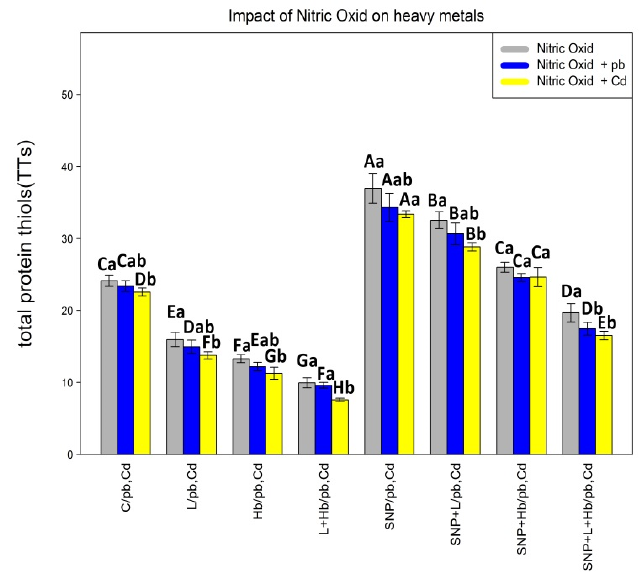
Figure 1. Effect of nitric oxide (NO) concentrations on protein, non-protein, and a total of thiol of A. pygmaea L. with 200 µ M Pb and 200 µ M Cd. The treatments contained various concentrations of nitric oxide alone or in combination with 200 µ M Pb and 200 µ M Cd. The capital letters showed statistically significant differences across various levels of nitric oxide alone or in combination with 200 µ M Pb and 200 µ M Cd (the bars with the same colors), while the lowercase letters showed statistically significant differences within each concentration of nitric oxide (NO) alone or in combination with 200 µ M Pb and 200 µ M Cd (the bars with different colors) according to Tukey’s test ( p < 0.05).